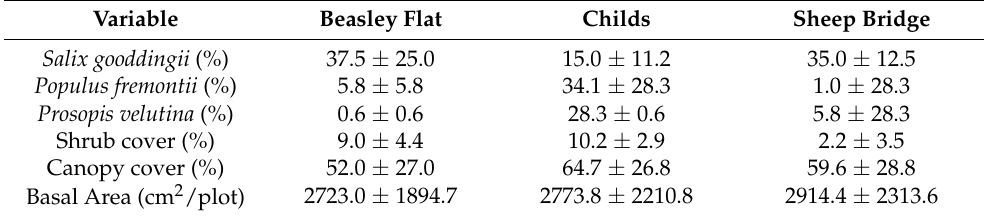
Table 2. Mean and SE of riparian vegetation traits measured at nine plots at three reaches paired with loggers to measure avian acoustic activity at Lower Verde River, Arizona